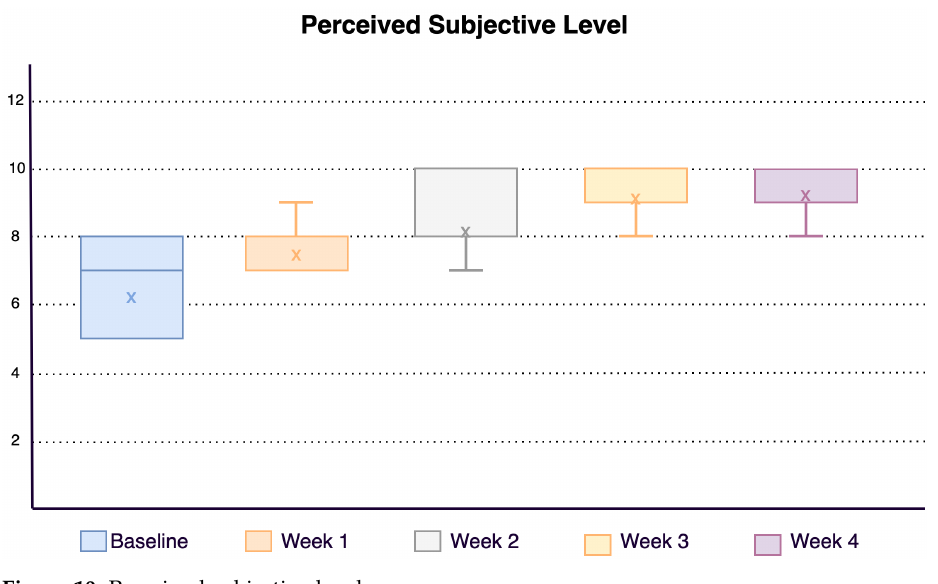
Figure 10. Perceived subjective